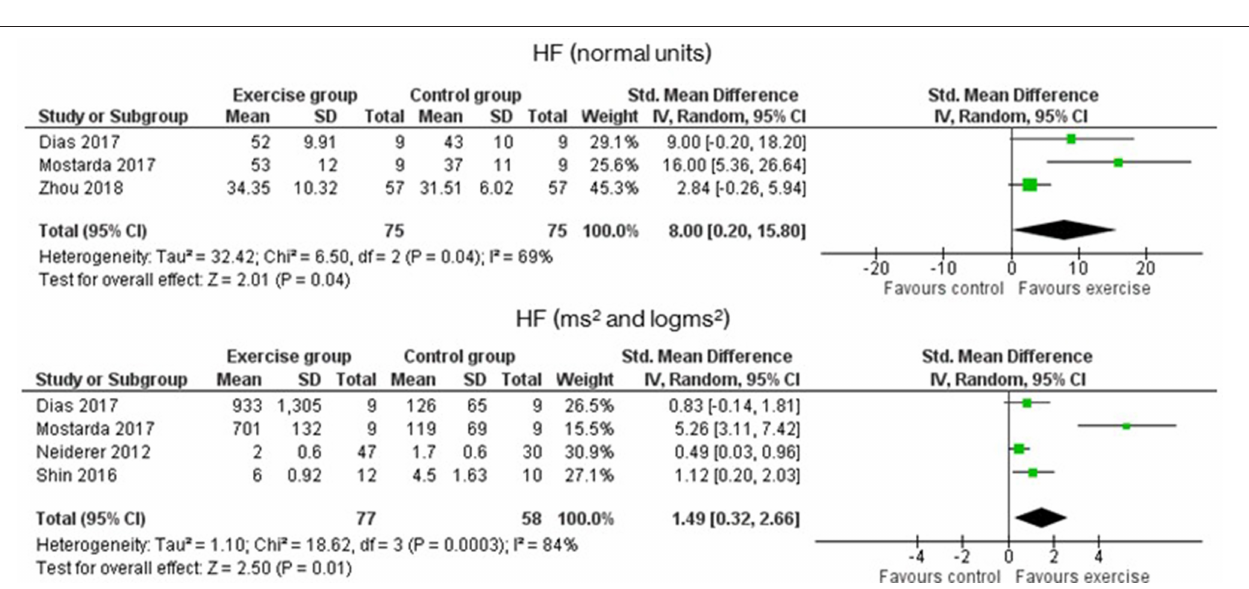
FIGURE 4 | Effects of exercise in HF (High Frequency) heart rate variability measure expressed in absolute (ms 2 ) and relative (n.u) power.